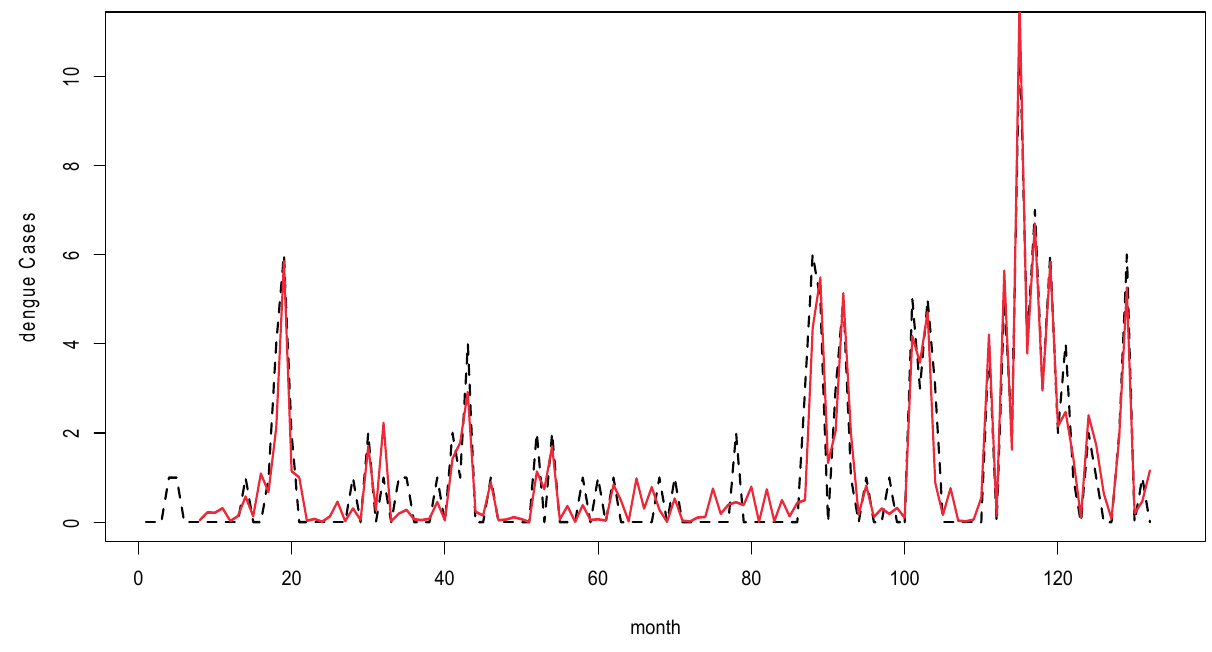
Figure 2. Reported dengue cases (black dotted line) and fitted cases (red line) generated by model for the years 2001–2011.